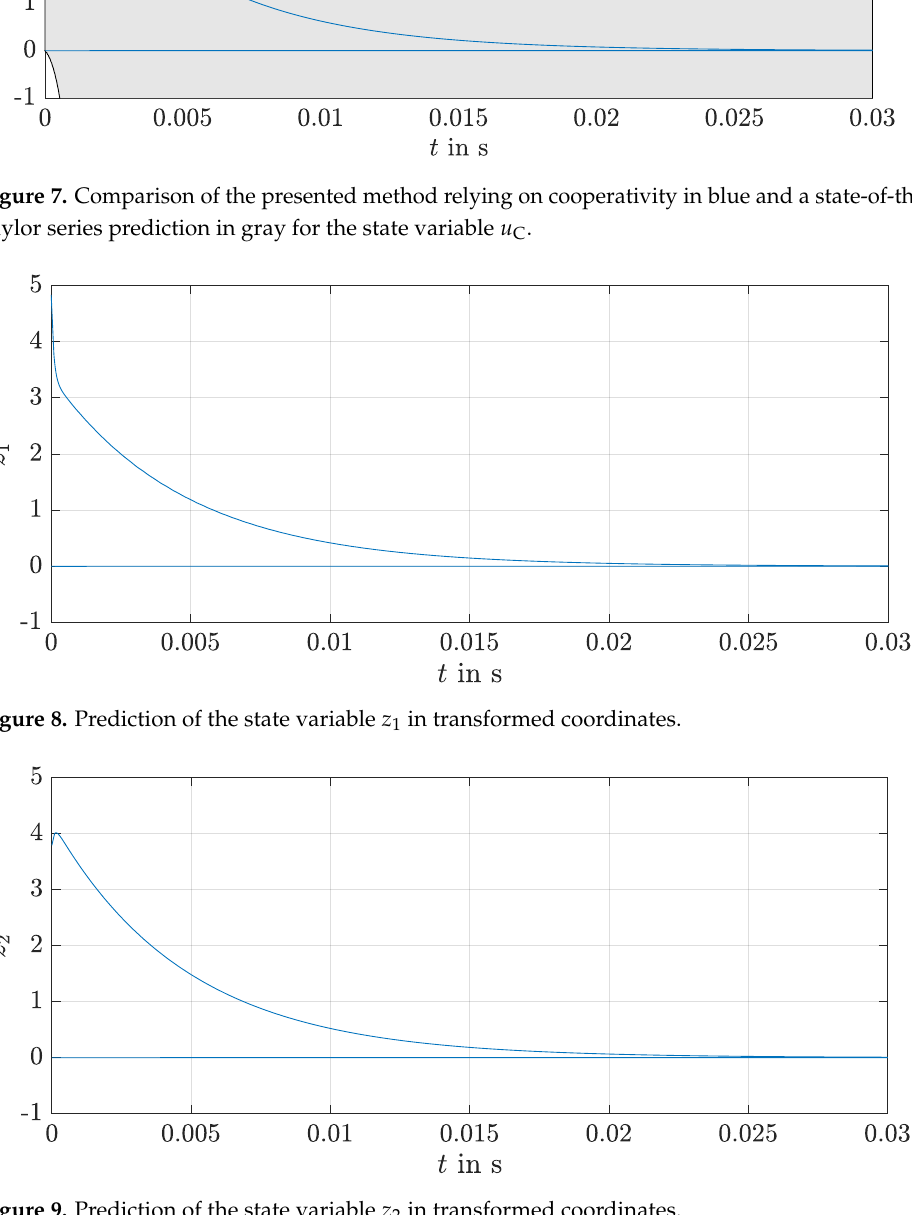
Figure 9. Prediction of the state variable z 2 in transformed